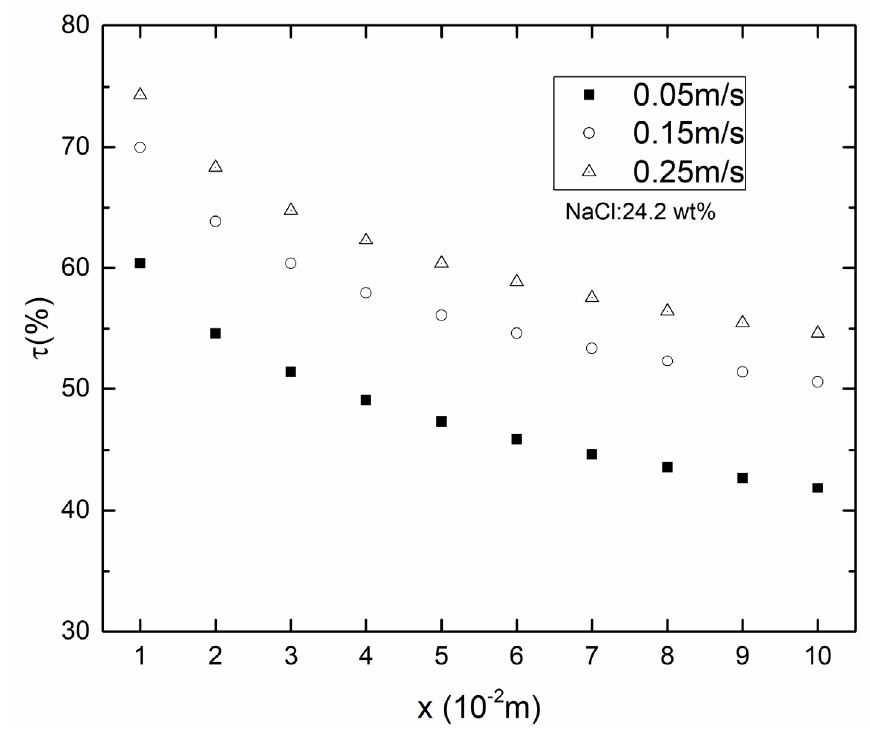
= 45 ◦ C, T = 25 ◦ C, c = 24.2 p f , v p ( T f f